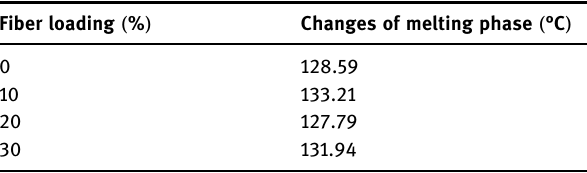
Table 2: Changes of melting phase of r - HDPE/bamboo